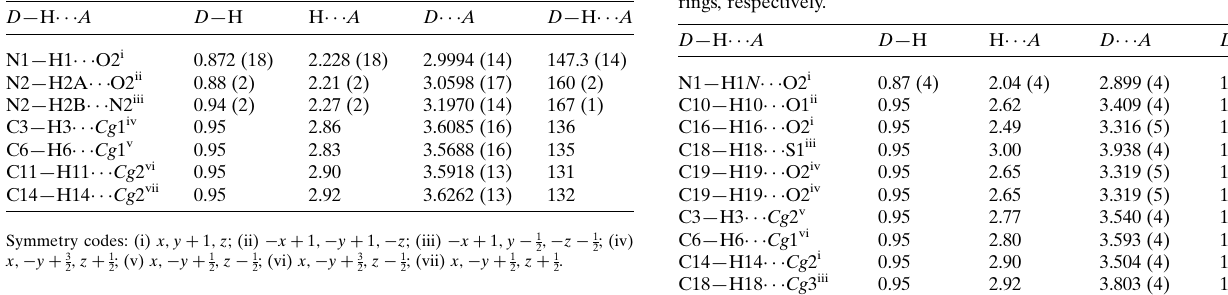
Table 1 Hydrogen-bond geometry (A˚ , (cid:3) ) for (I).